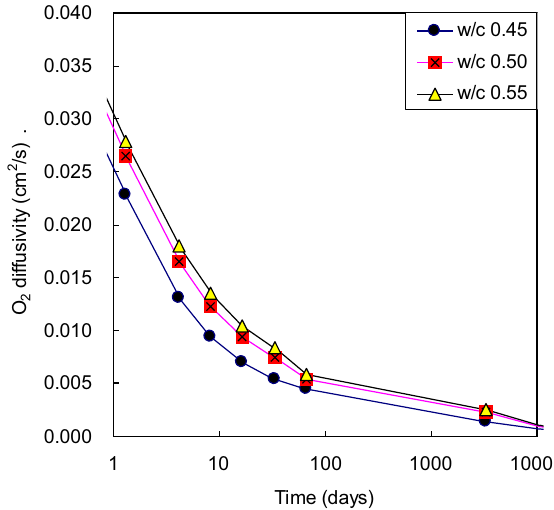
Fig. 8 Apparent oxygen diffusivity of carbonated concrete with apparaent pore.